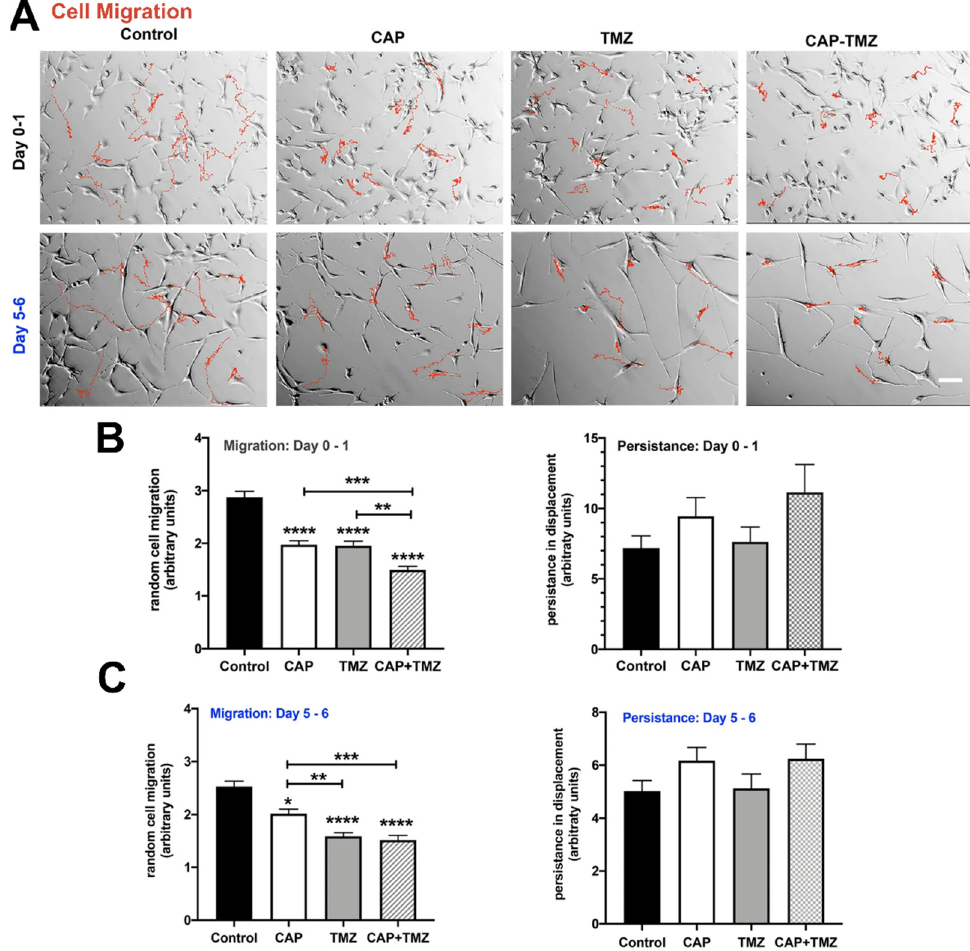
Figure 6. The impact of cold atmospheric plasma (CAP) on cell migration. ( A ) Control (untreated), CAP-only (180 s), TMZ-only (50 µM), and combined CAP–TMZ treated cells. Red indicates the trajectories of 10 representative cells evaluated during a 16 h period on Day 0–1 and Day 5–6. Images were captured every 10 min until a total of 100 images were acquired. The CAP-TMZ condition results in shorter cell migration paths than the control variables ( B , C ). The graphs illustrate the velocity and displacement of 60 cells per variable. Persistence was calculated as the ratio of net displacements to total displacements. Unless otherwise specified, error bars represent the standard error of the mean, and an asterisk denotes statistical significance relative to untreated control. Scale bar: 14 µm. Statistical significance was determined as: * p < 0.05; ** p ≤ 0.01; *** p ≤ 0.001, **** p ≤ 0.0001. Figure adapted with permission from Ref. [204]. 2020, Gjika